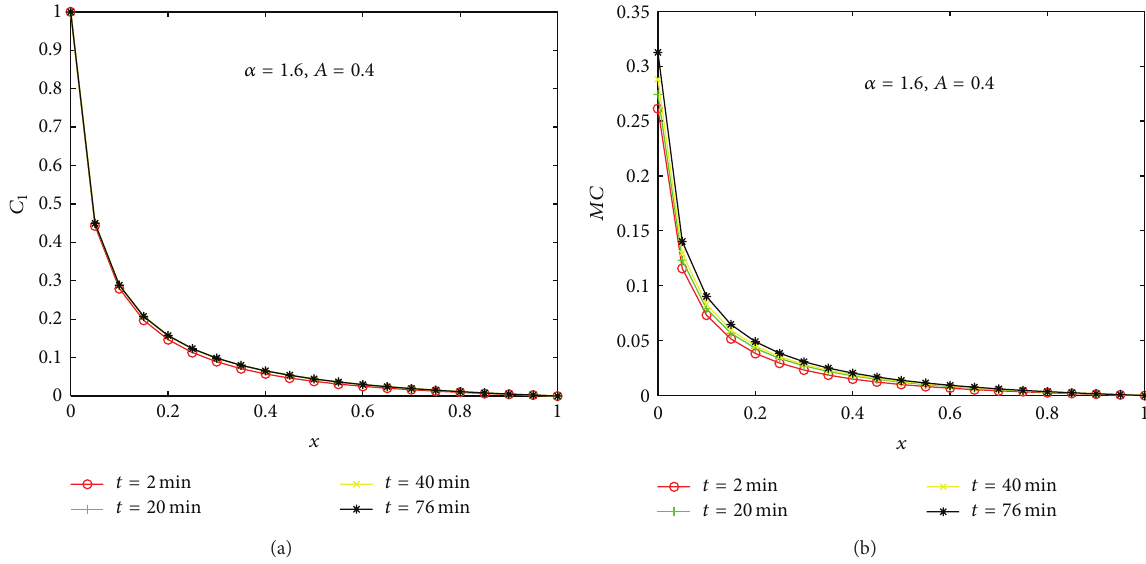
Figure 4: (a) is 𝐶 1 , plotted against 𝑥 at different times when 𝛼 = 1.6 , 𝐴 = 0.4 ; (b) is 𝑀𝐶 , plotted against 𝑥 at different times when 𝛼 = 1.6 , 𝐴 = 0.4 .